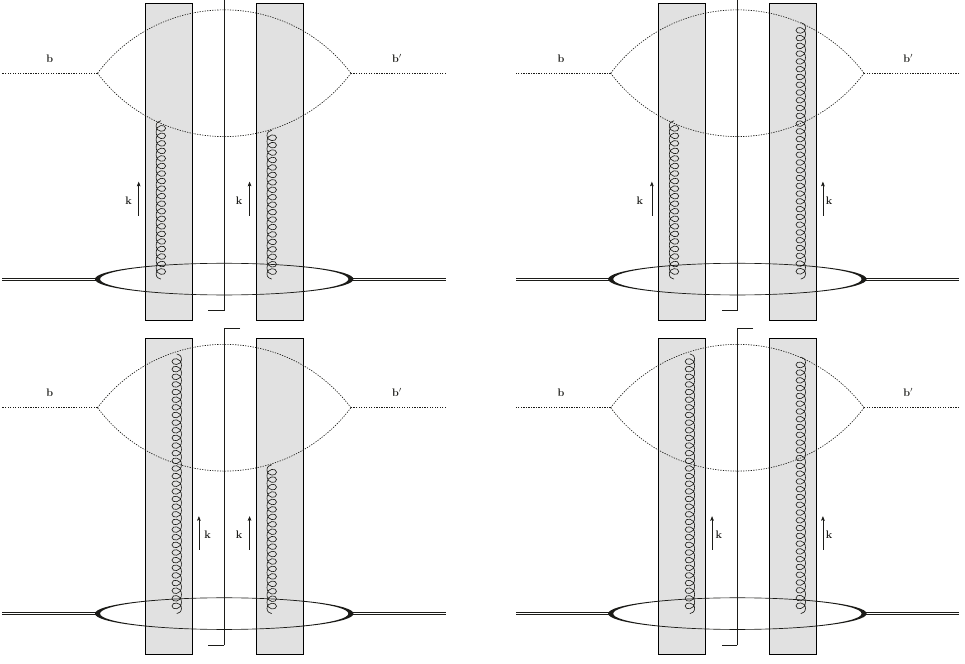
Figure 1 . 2-body contributions to the inclusive cross section. The gray blobs represent interactions with low k + gluons via Wilson lines, and the gluon line is isolated from the gauge link contributions by differenciation of a Wilson